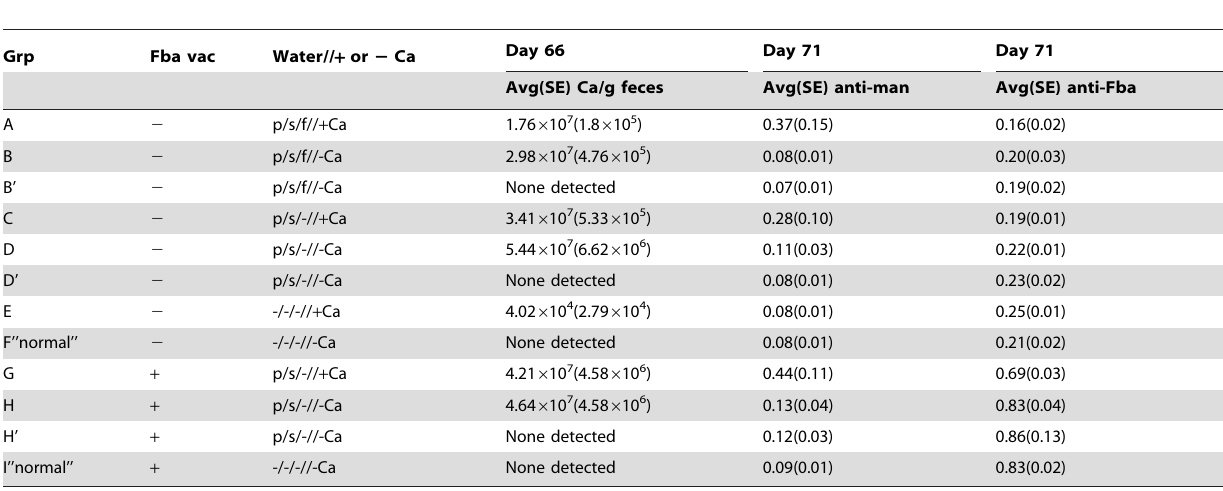
Table 3. Treatment schedule and results of experiment to address horizontal transmission and antibody responses due to GI-tract colonization and Fba